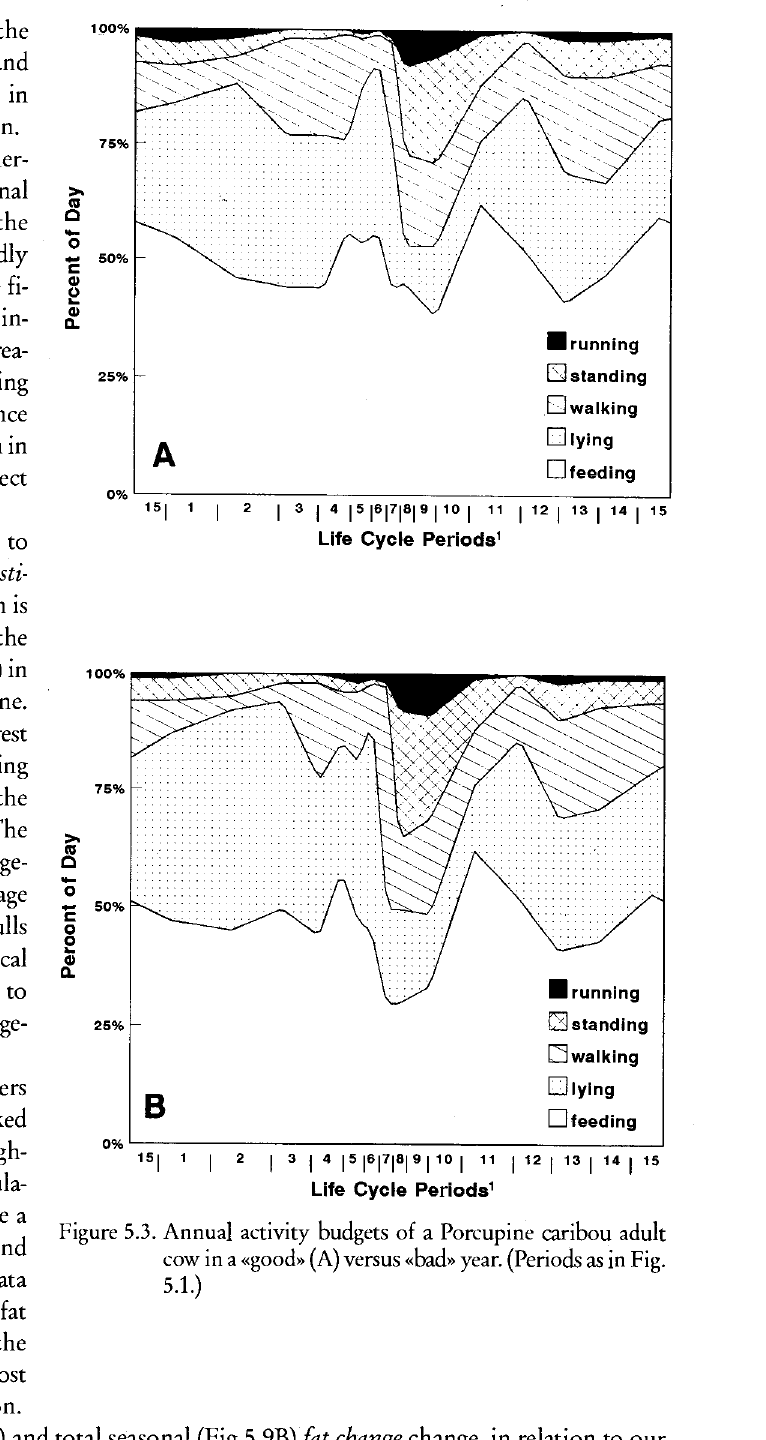
Figure 5.3. Annual activity budgets of a Porcupine caribou adult cow in a «good» (A) versus «bad» year. (Periods as in Fig.